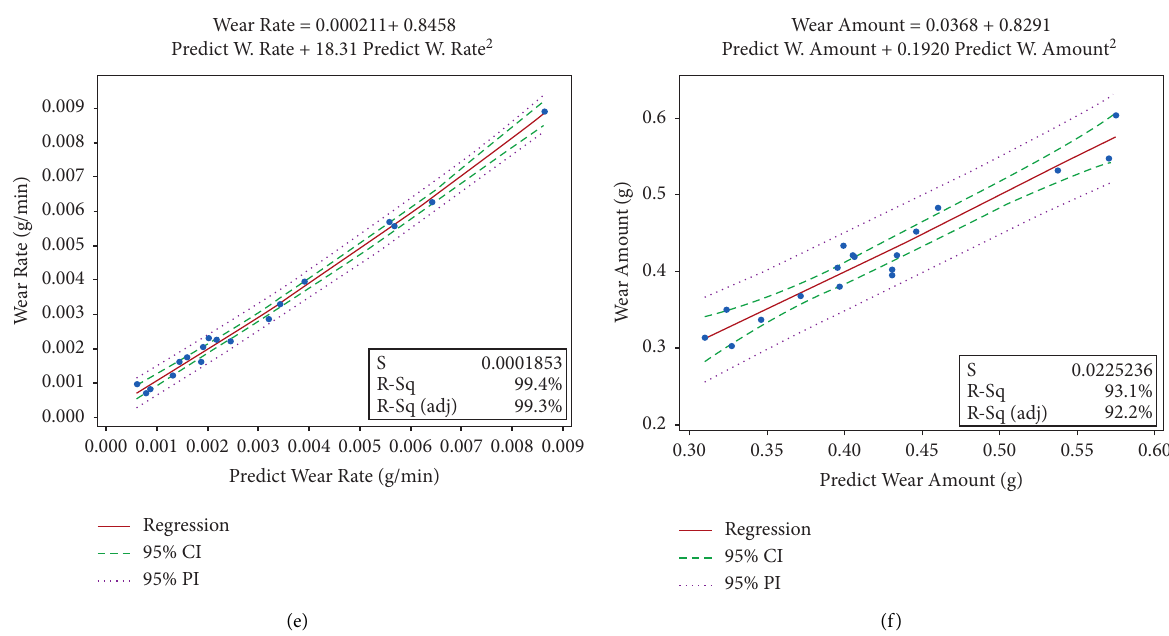
Figure 11: Graphs of estimated results and results obtained from experiments ((a) surface roughness, (b) hole diameter, (c) crater diameter, (d) wear amount, (e) wear rate, and (f) processing time).